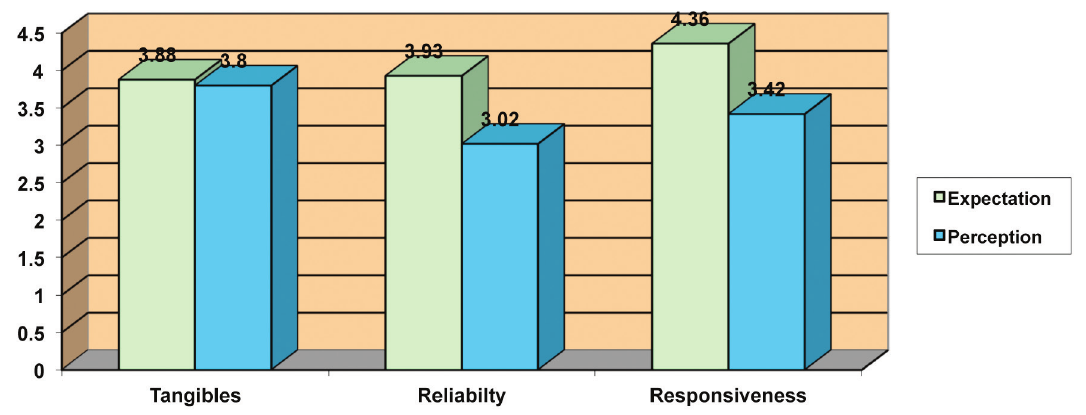
Figure 4: Service quality dimensions: Expectations versus